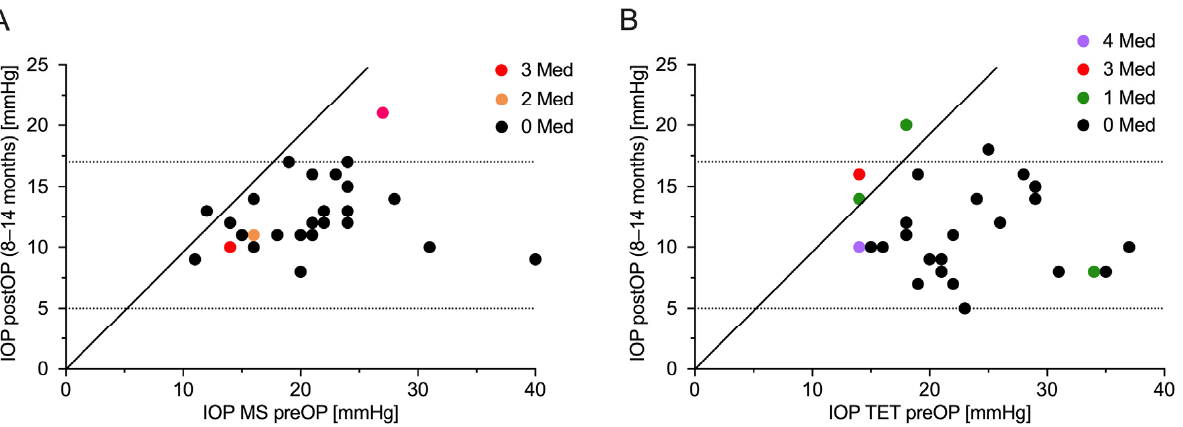
Figure 2. Scatter plot of intraocular pressure preoperatively versus one year postoperatively. ( A ) MicroShunt implantation and ( B ) trabeculectomy. The dotted lines represent the limits of surgical success, plotted according to the number of antiglaucomatous medications at one year postoperatively. IOP = intraocular pressure; MS = MicroShunt implantation; Med = antiglaucomatous medication; preOP = preoperative; postOP = postoperative; TET = trabeculectomy.